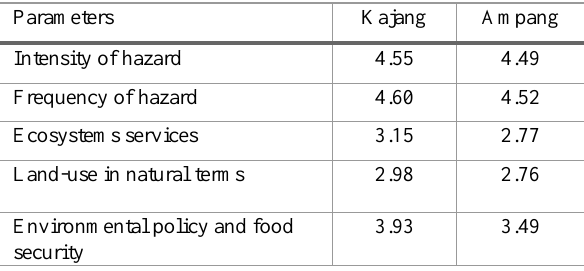
Table 6: Assessment of Natural Component. Source: